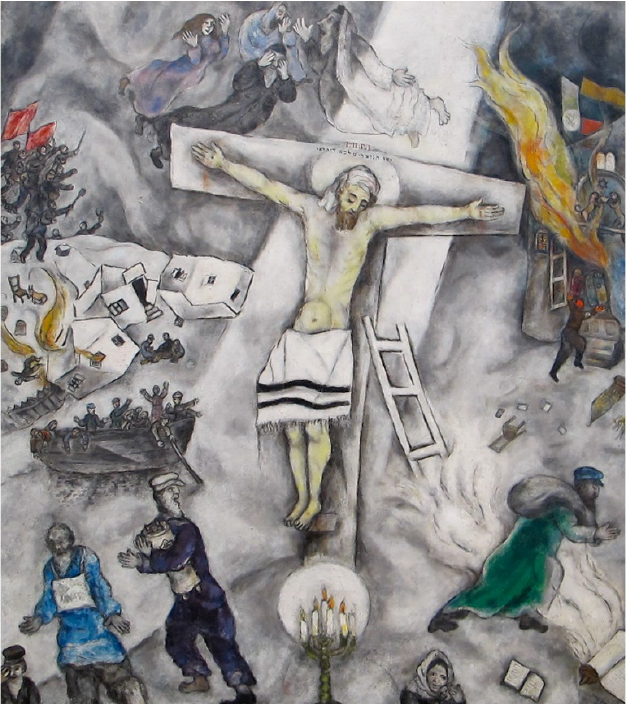
Figure 1. Marc Chagall, White Crucifixion , 1938. The Art Institute of Chicago. © 2018 Artists Rights Society (ARS), New York/ADAGP, Paris, also made available under Creative Commons Zero (CC0). Image courtesy Ed Bierman, licensed under CC BY 2.0. To view a copy of this license, visit https://creativecommons.org/licenses/by/2.0/?ref=openverse (accessed on 5 A ugust 2022).